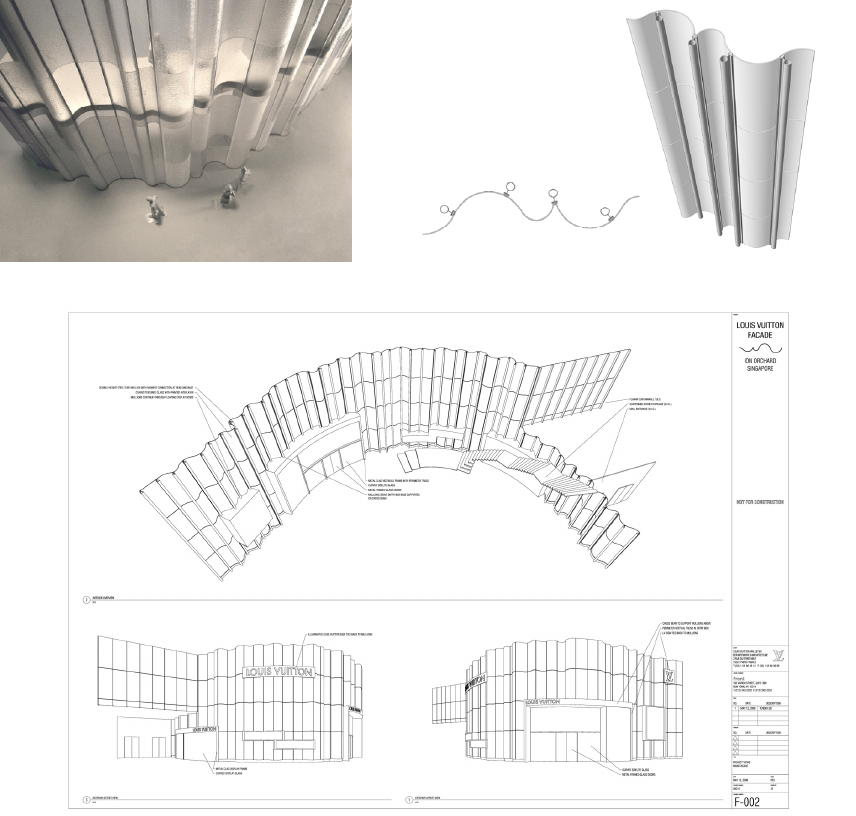
Figure 18a, b, c: Study Model, Perspective Views, Mullion to Glass